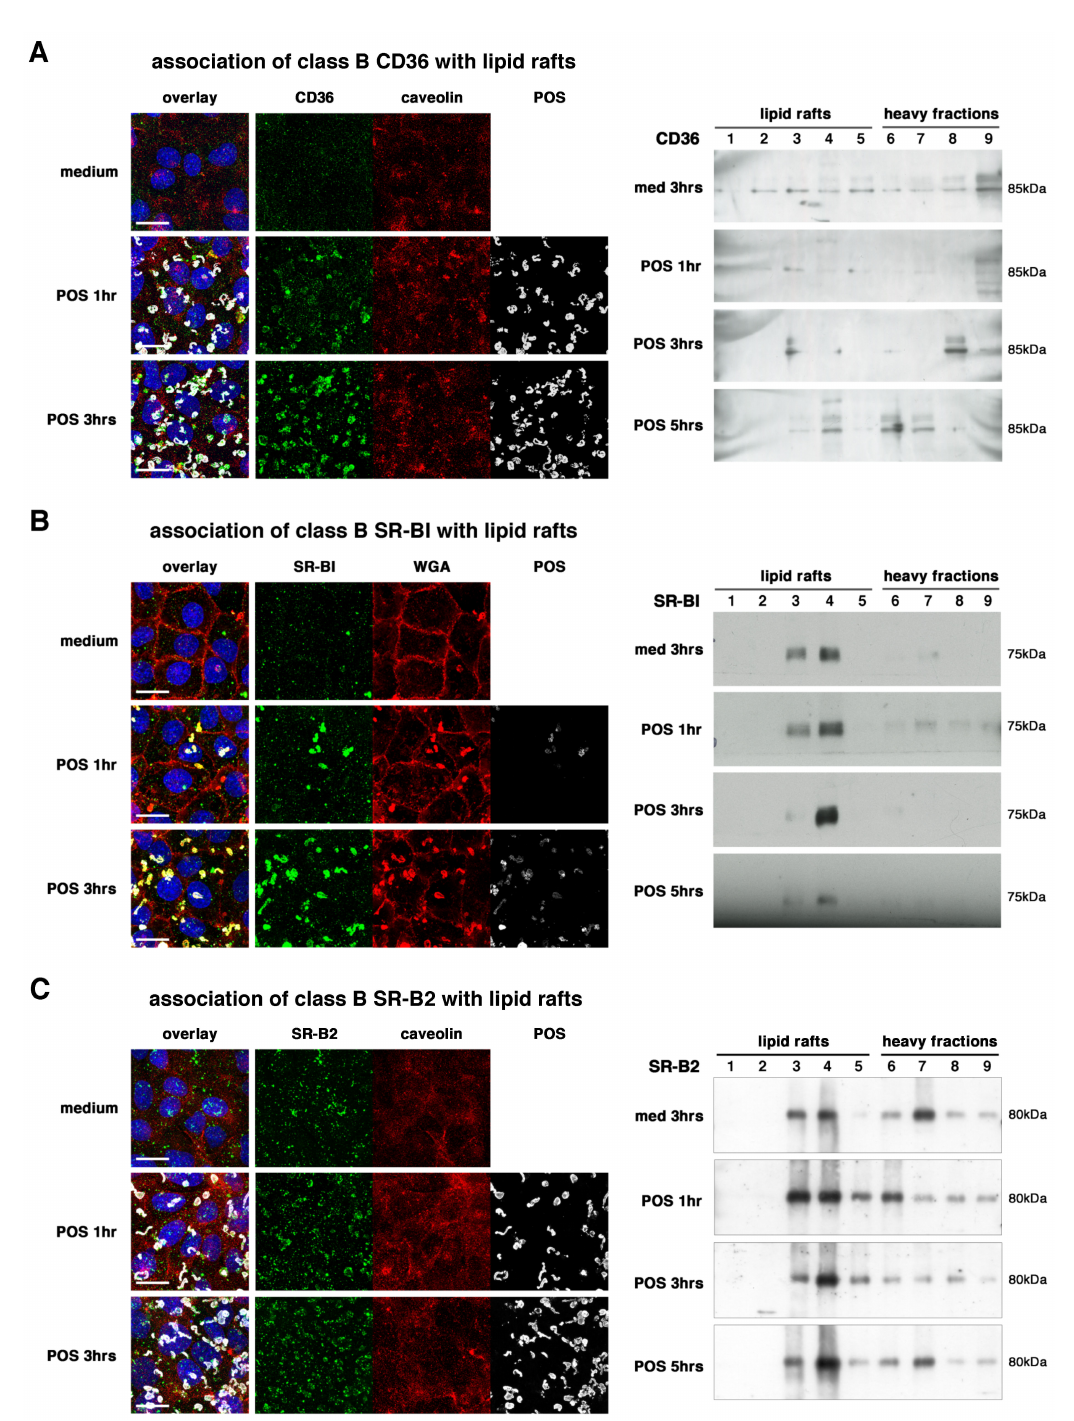
Figure 3. Association of class B scavenger receptors with lipid rafts. Immunocytochemistry labelings ( A – C ) show that CD36 ( A ) and SR-B2/LIMP-2 ( C ) receptors (green) associate with lipid rafts marker caveolin (red) ( A , C ) after 1 (POS 1 hr) and 3 (POS 3 hrs) hours of POS (grey) challenge when compared to medium incubation as indicated. Overlay panels (left) include nuclei (blue). Scale bars: 20 µ m. SR-BI shows a strong association with N-acetyl glucosamine (GlcNAc)-related oligosaccharides marker WGA present on cell surface-expressed proteins ( B ). Immunoblots of flotation gradients ( A – C ) confirmed that CD36 ( A ), SR-B2/LIMP-2 ( C ), and to a lower extent SR-BI ( B ) relocalize to membrane fractions corresponding to lipid rafts (1–5) from heavier fractions (6–9) at 3 and 5 hours (POS 3 hrs, POS 5 hrs) (CD36, ( A ); SR-BI, ( B )) or at 3 hours only (SR-B2/LIMP-2, ( C )) when compared to a 3 -hour incubation with medium (med. 3 hrs), as